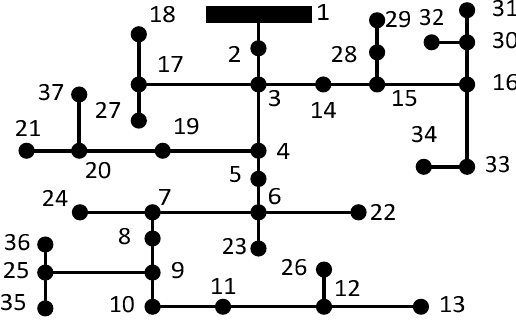
Figure 3. The single line diagram of IEEE-37 bus test system.